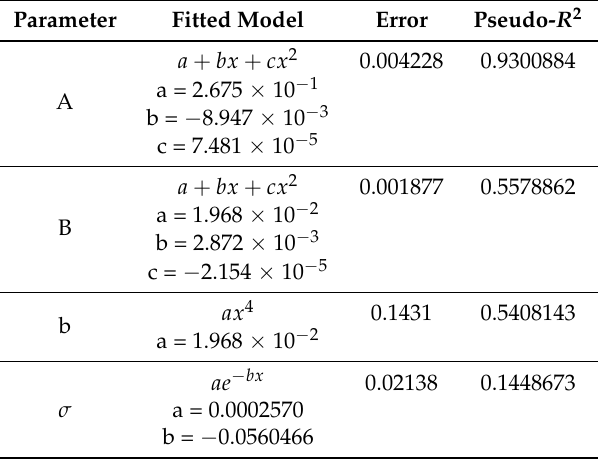
Table A1. Nonlinear regression results, HW